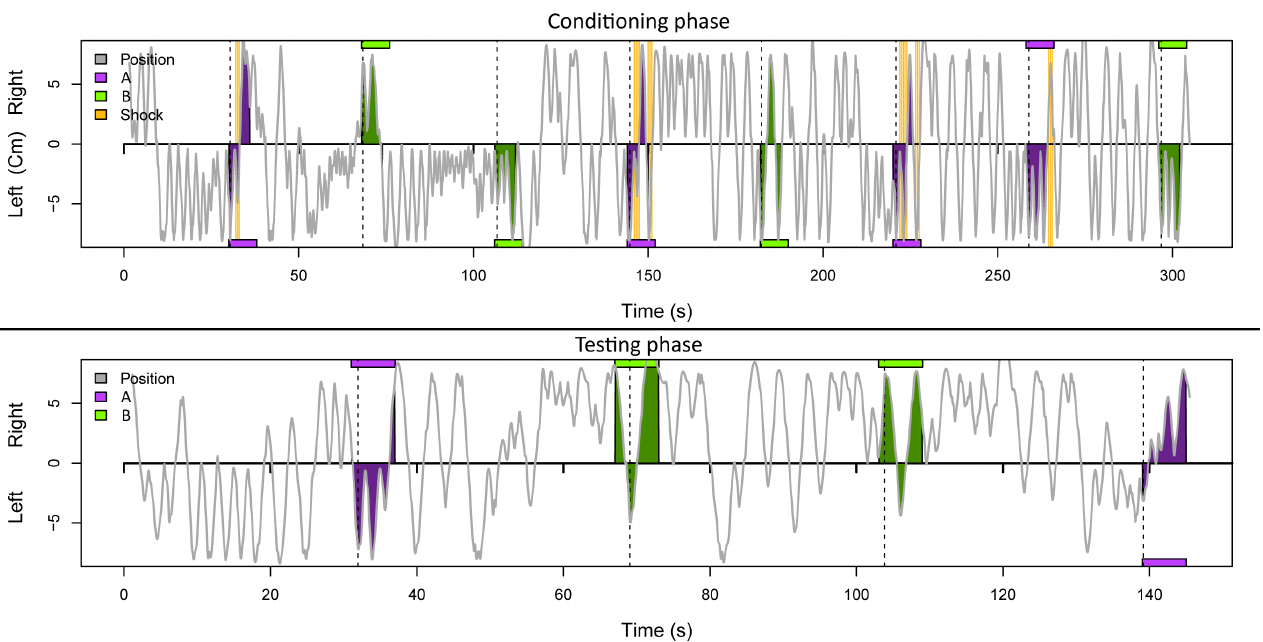
Fig 3. Example plot showing an individual honeybee conditioning experiment. The gray line indicates the walking trace from left to right in the conditioning chamber. Magenta and green boxes indicate heroin and cis -3-hexenol odor stimuli, respectively, and the side from which the odor was applied. Yellow lines indicate shock impulses. The upper plot shows the conditioning phase, the lower plot the test phase without shocks after a 5-min interval.